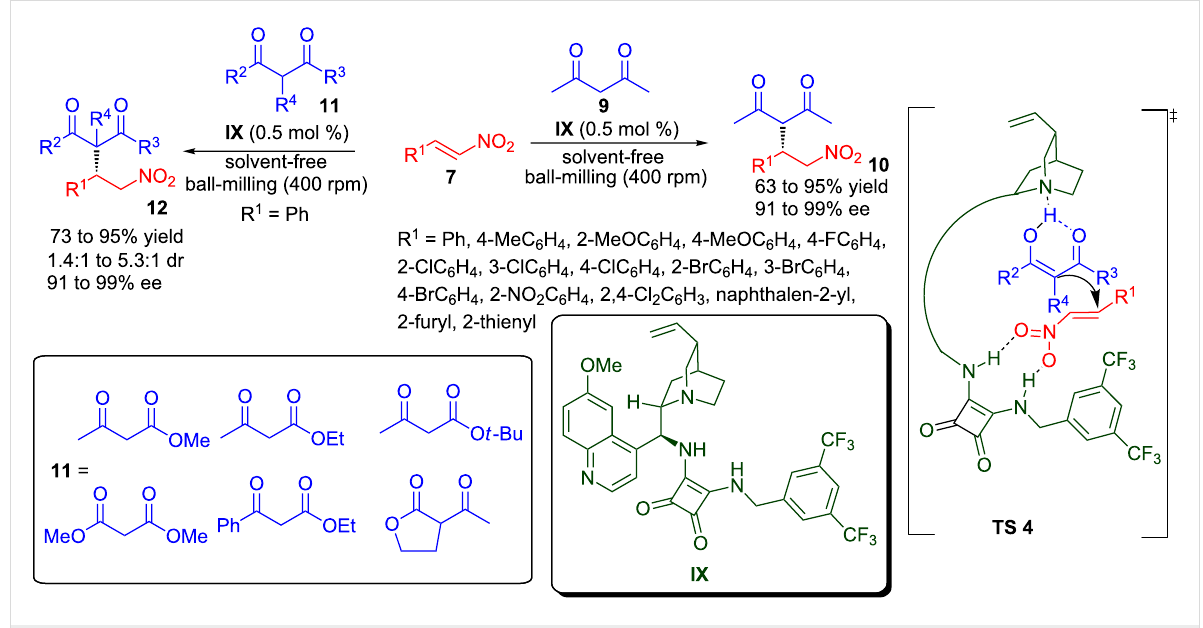
Scheme 7: Chiral squaramide catalysed asymmetric Michael reaction assisted by